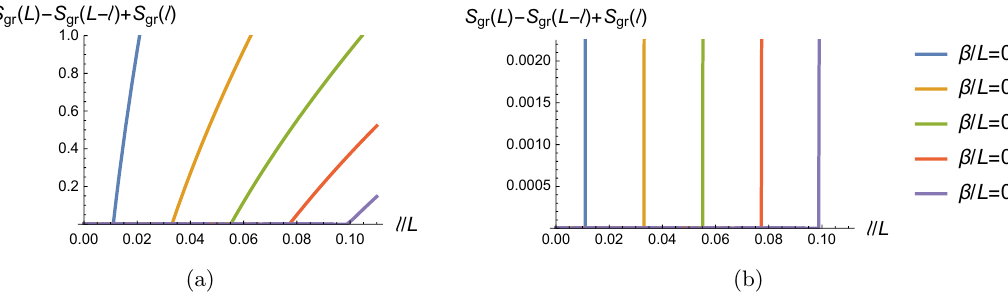
Figure 1 . Holographic entanglement plateau in AdS 3 /CFT 2 . The Araki-Lieb inequality is satu- rated for a small enough critical length ‘ (cid:20) ‘ gr is the one being zoomed in around zero. It is obvious that there exists a critical length ‘ gr is smaller than which (cid:1) S